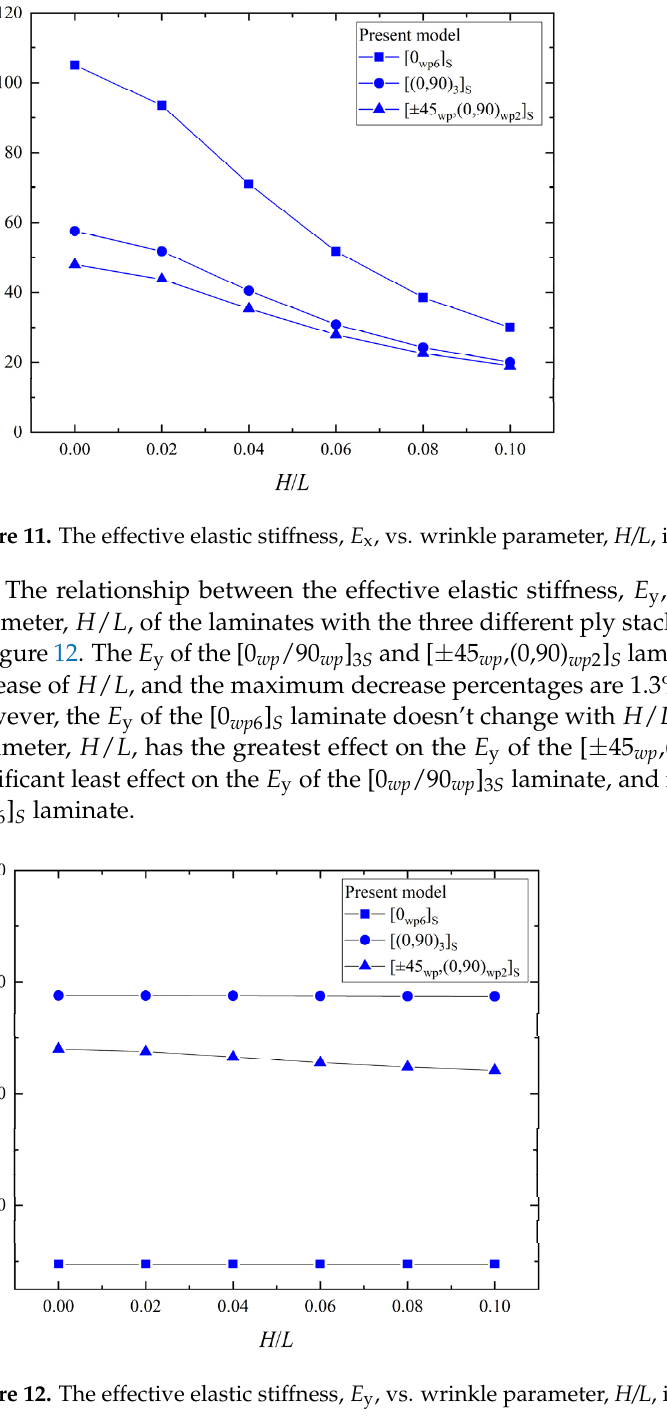
, and the wrinkle defect param- z